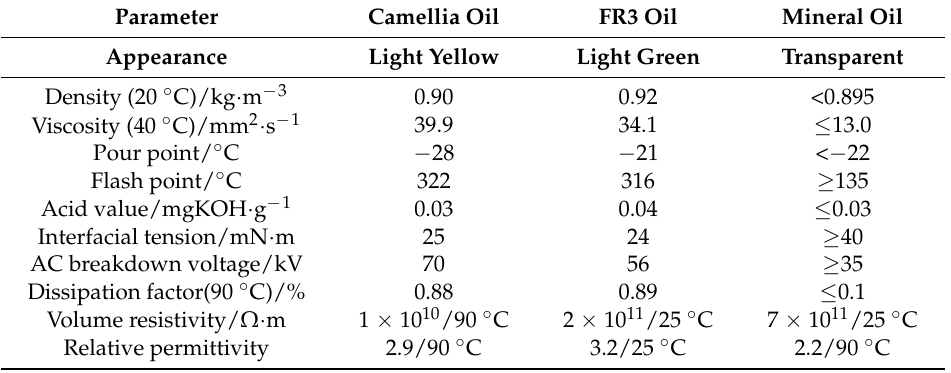
Table 1. Basic physical, chemical and electrical properties of vegetable oils and a mineral oil